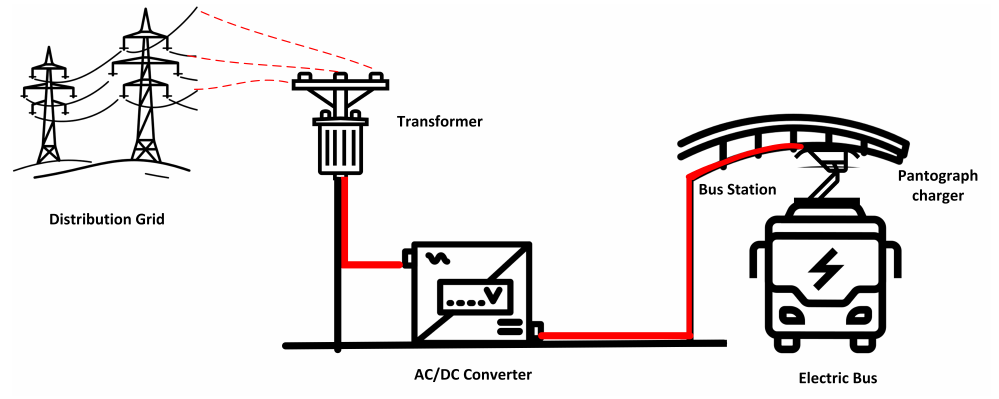
Figure 5. Representation of electric bus charging infrastructure’s connection with a power